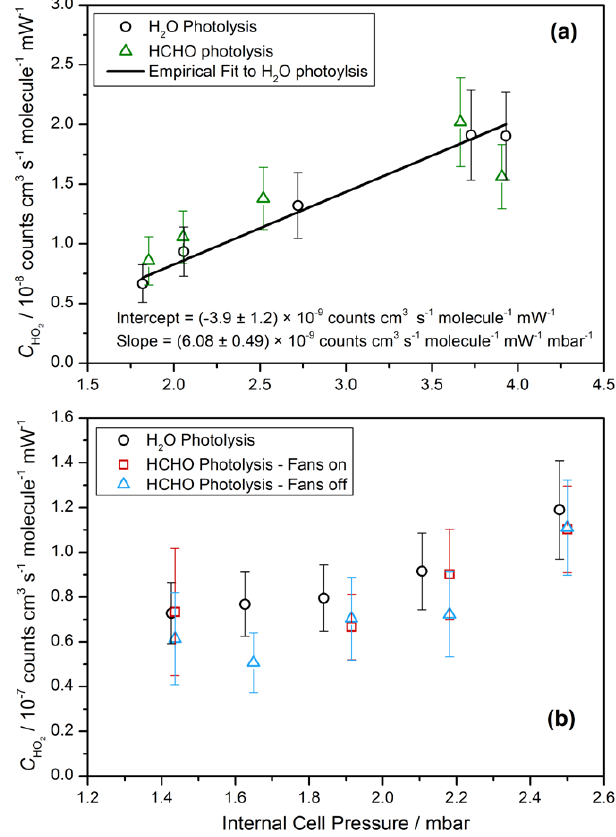
Figure 10. FAGE instrument sensitivity to HO 2 , C HO function of internal detection cell pressure as determined by the H 2 O vapour and HCHO photolysis calibration techniques us- ing the HIRAC FAGE instrument operating at 200Hz PRF (a) and the aircraft FAGE instrument operating at 5kHz PRF (b)